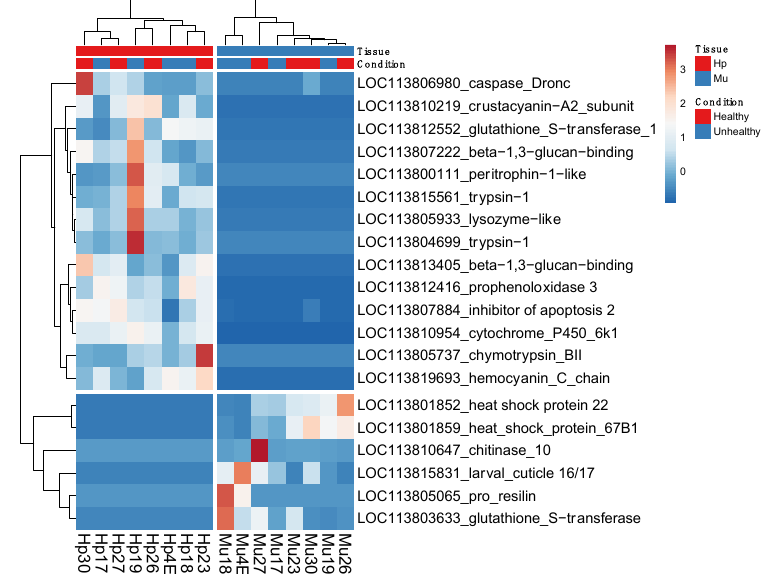
Figure 3. Themostdifferentiallyexpressedgenesincommonforhepatopancreas(Hp)andWSSV-negative (Healthy); and muscle (Mu) and WSSV-positive (Unhealthy) Litopenaeus vannamei shrimps. Unit variance scaling is applied to rows. Both rows and columns are clustered using correlation distance and average linkage. The numbers 0, 1, 2, and 3 in the color scale represent the normalization z-score values. The counts per million normalized reveals the clear difference in Hp and Mu expression patterns represented in a heatmap. The samples from these tissues are grouped separately. Intense red rectangles represent the samples with greater number of read counts for a particular gene. WSSV: White Spot Syndrome